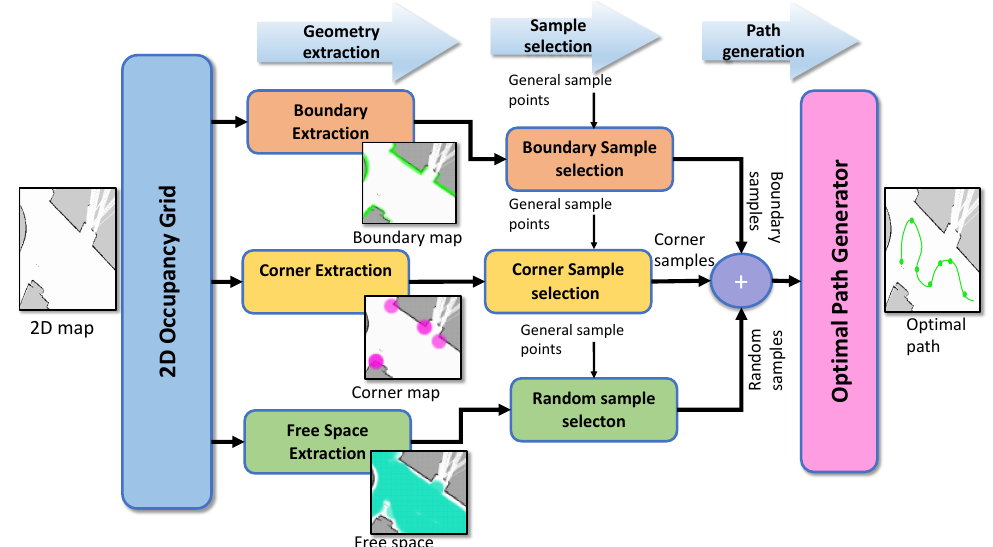
Figure 2. The overview of the proposed path generation strategy for dirt sample gathering using geometrical signatures extracted from the 2D map of the environment combined with an optimal path